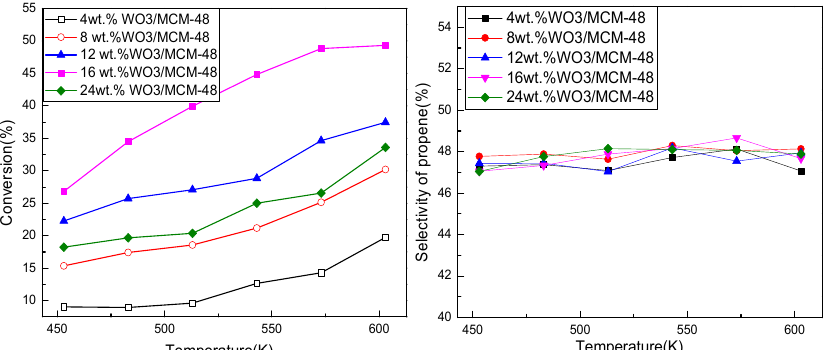
Figure 3. Propene selectivity and butene conversion over catalysts with different loadings. Reaction conditions: P = 0.8 MPa; WHSV = 3.2 h −1 .